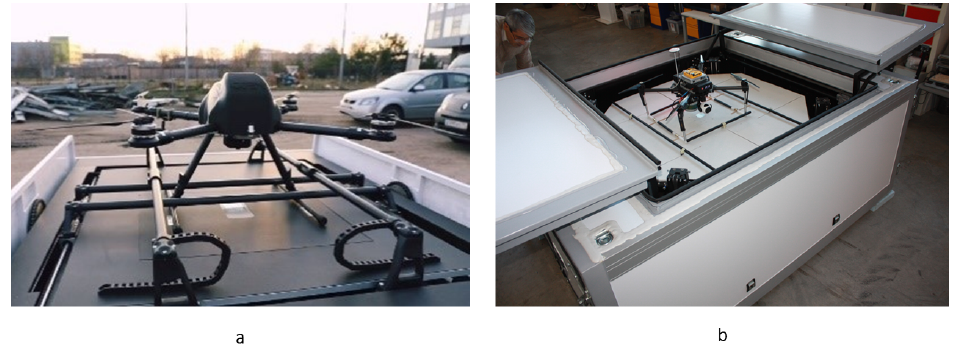
Figure 11. Examples of commercially available platforms for UAVs with 4 parallel pushers by: ( a ), COEX [47]; and ( b ), Innopolis University